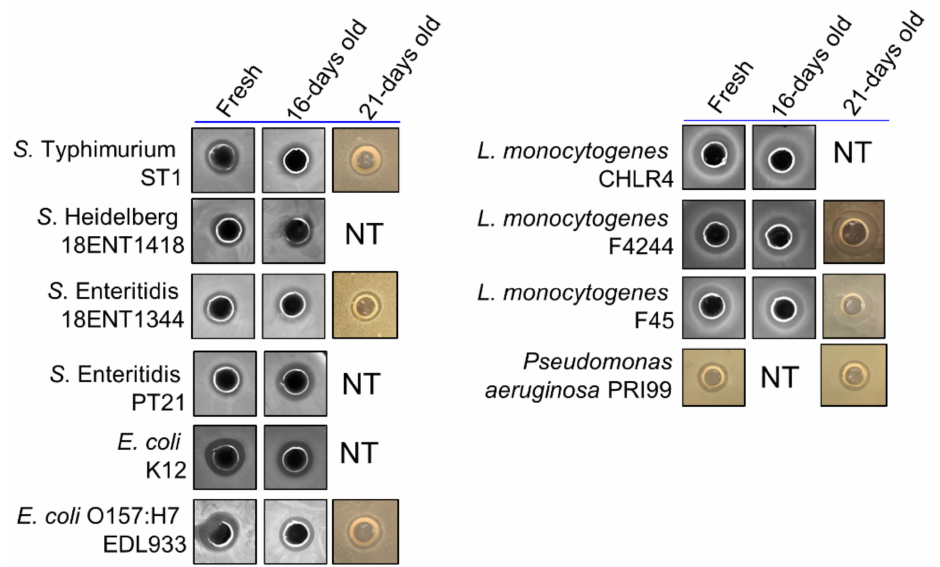
Figure 3. Comparison of the antimicrobial activities (zone of inhibition) of fresh ChNP-PL and ChNP-PL stored at ambient temperature for 16–21 days using an agar gel diffusion method. NT: not